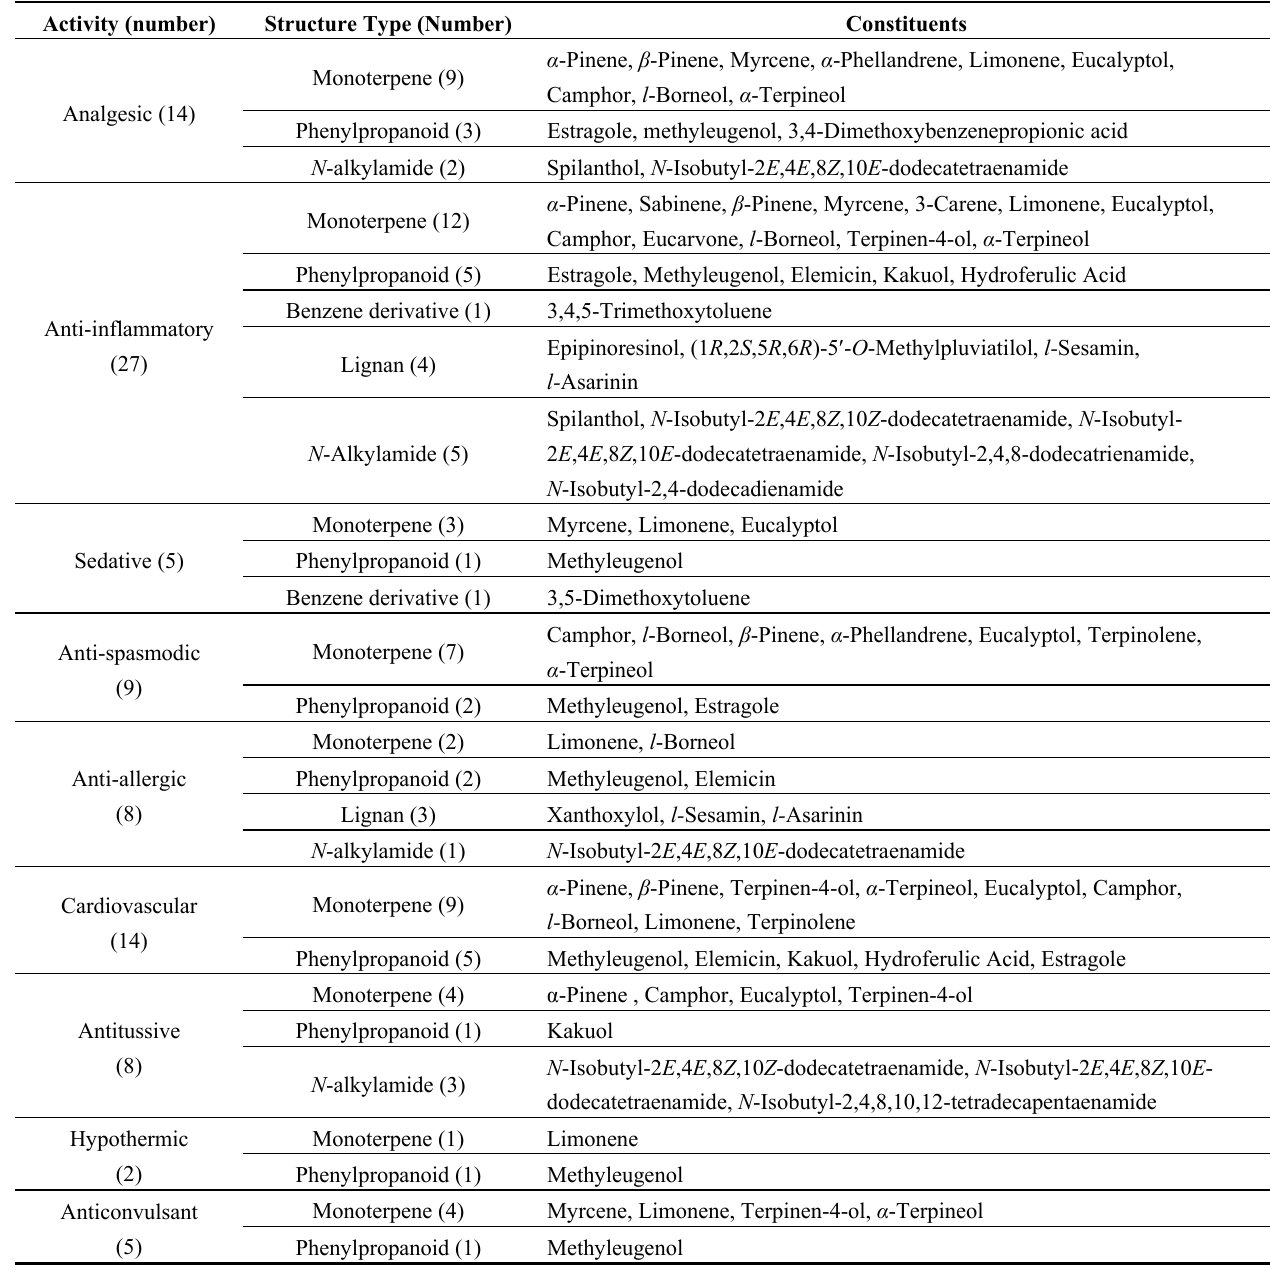
Table 5. Bioactivities of the absorbed constituents related to the pharmacological effects of Asari Radix et Rhizoma